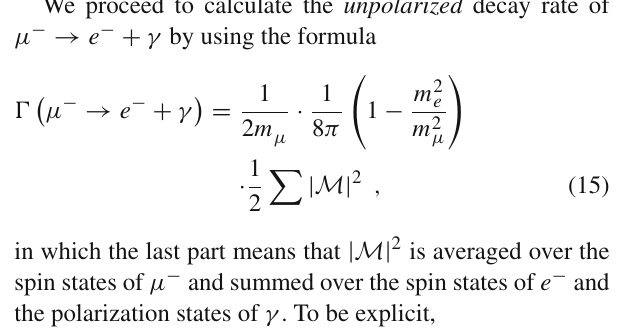
(cid:24) (cid:25) x and the analytical approximations given in i (cid:2) 0 . 1, 0 . 1 (cid:2) x (cid:24) (cid:25) i x corresponding to the regimes of x i